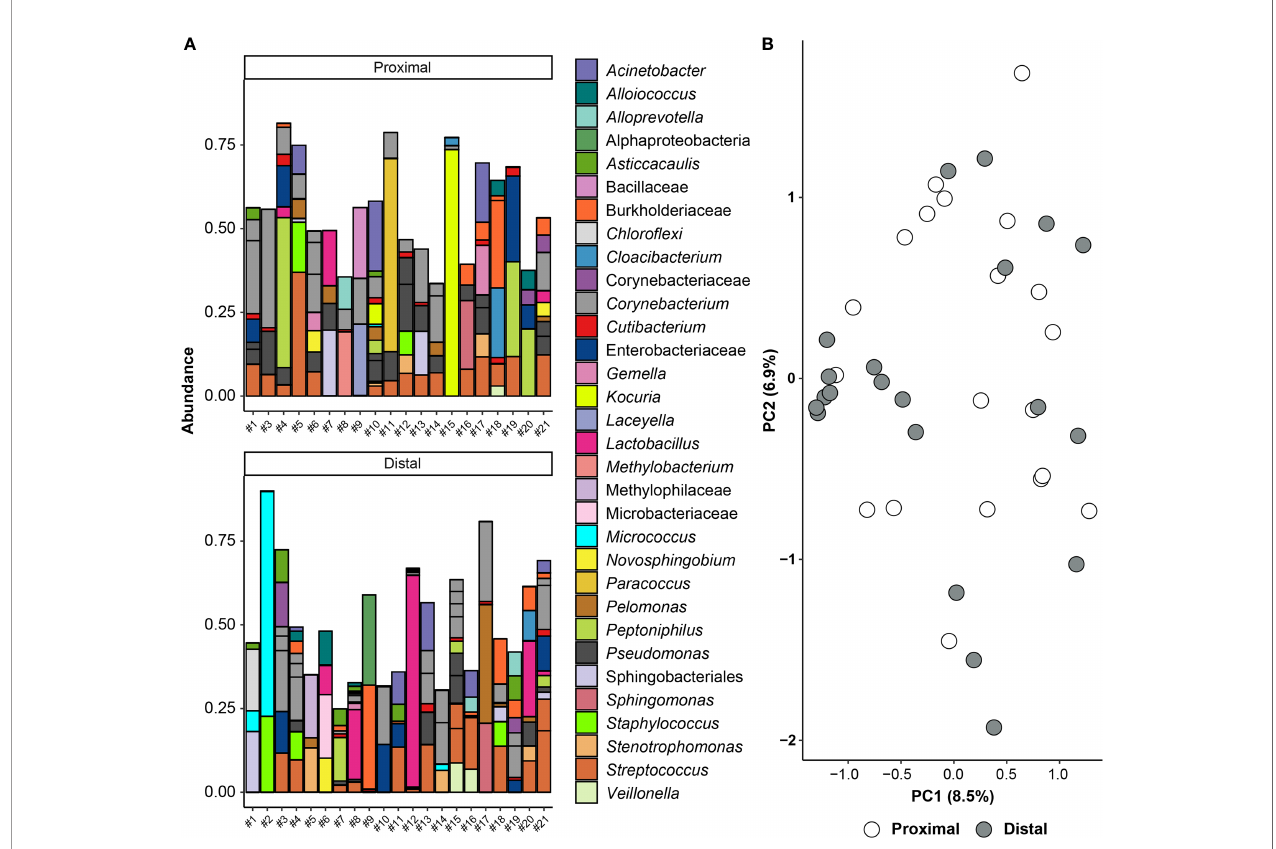
FIGURE 4 | Amniotic fl uid sequencing results after the removal of likely contaminating sequences. (A) Bar graph showing the taxonomy of the 45 amplicon sequence variants (ASVs) with highest relative abundance across all proximal and distal amniotic samples. Bars of identical color within the same sample indicate multiple ASVs with the same bacterial taxonomic classi fi cation. The DNA extract of the proximal amniotic fl uid sample from Dam #2 did not yield a 16S rRNA gene sequence library. (B) Principal coordinate analysis (PCoA) illustrating variation in 16S rRNA gene pro fi les among proximal and distal amniotic fl uid samples. The 16S rRNA gene pro fi les were characterized using the Bray-Curtis similarity